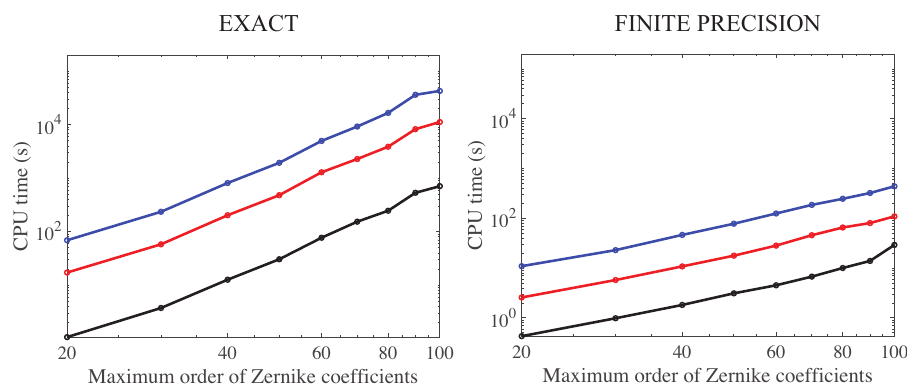
Figure 13. CPU times required to compute the Zernike moments of a sphere as a function of the maximum order N of those Zernike moments. We computed the Zernike moments for three discrete representations of the sphere, each given by a triangular mesh. The corresponding meshes include 20,480, 81,920 (black line), and 327,680 (red line) triangles, respectively. Linear fits to these curves give slopes of 4.2 for the exact algorithm and 2.4 for the finite algorithm, corresponding to apparent complexities of O ( N 4.2 ) and O ( N 2.4 ) for those two